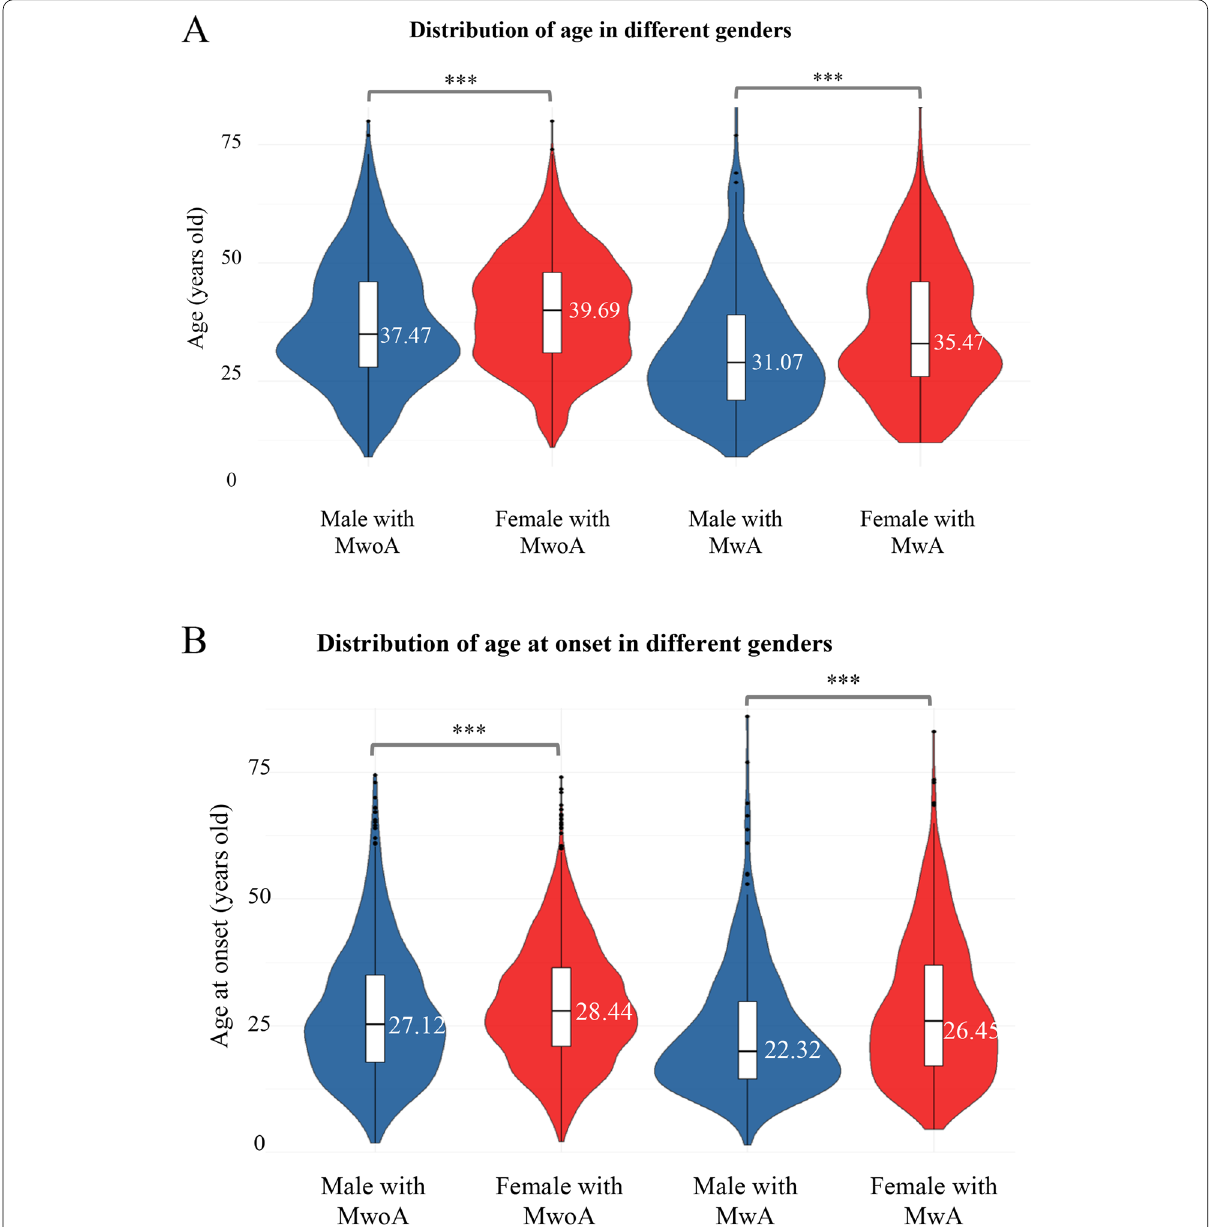
Fig. 2 Distribution of age and age at onset in MwoA and MwA patients. Parameters of age and age at onset for different groups are presented as boxplots, which indicate the median and quartiles with whiskers reaching up to 1.5 times the interquartile range. The violin plot shows the kernel probability density, i.e., the width of the shaded area represents the proportion of the data located therein. The average age of MwA group was younger than MwoA group (34.14 13.67 years vs. 39.33 11.96 years, p < 0.0001), and the age at onset was also younger in MwA group ± ± (26.57 13.57 years vs. 28.72 11.94 years, p < 0.0001). *: p < 0.05, **: p < 0.01, ***: p < ± ±